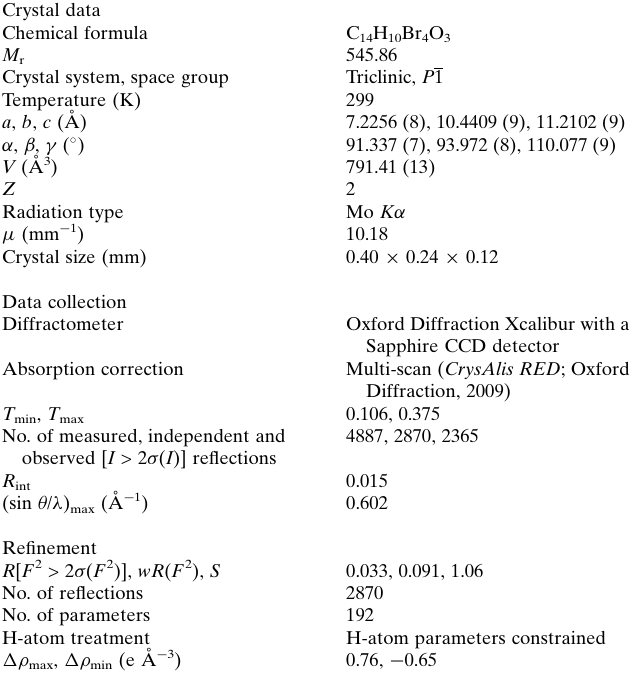
Table 2 Experimental details. Crystal data Chemical